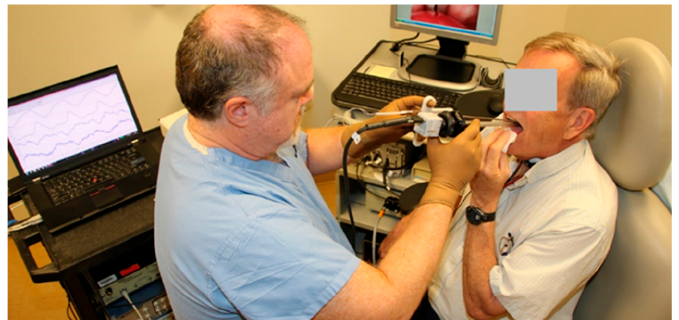
Figure 12. Illustration of a clinician holding a left-handed ISP probe that is designed to measure the left vocal fold collision pressure. The clinician’s right hand operates a standard camera sensor for standard video or video stroboscopic